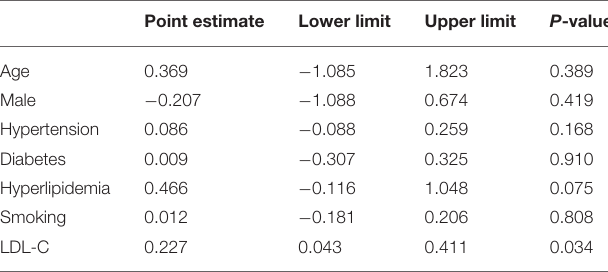
TABLE 5 | Meta-regression of influence factors for micovessel in healed plaque among SAP